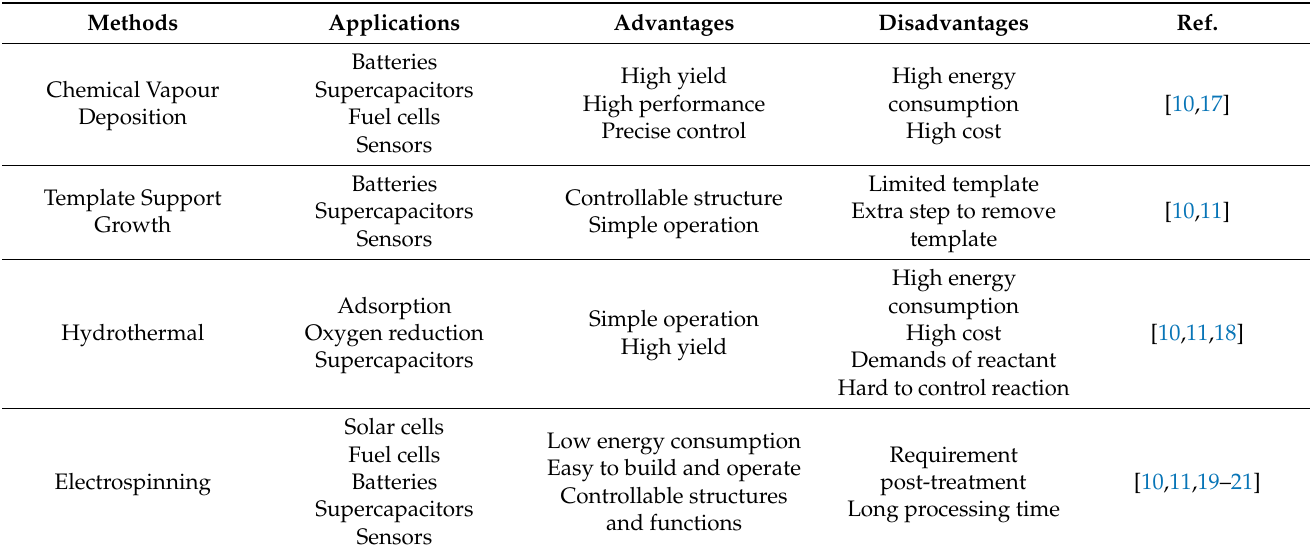
Table 1. Comparison of the main carbon nanofibre synthesis methods and